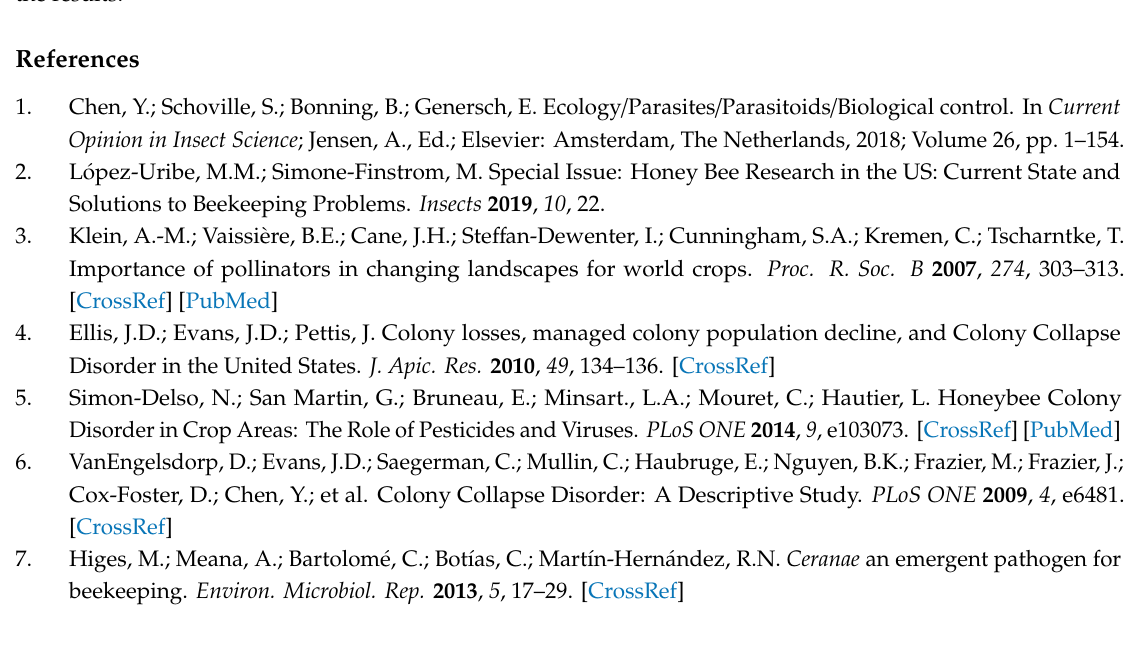
Table S1: Locations of hives sampled in this study, Table S2: All compounds identified on